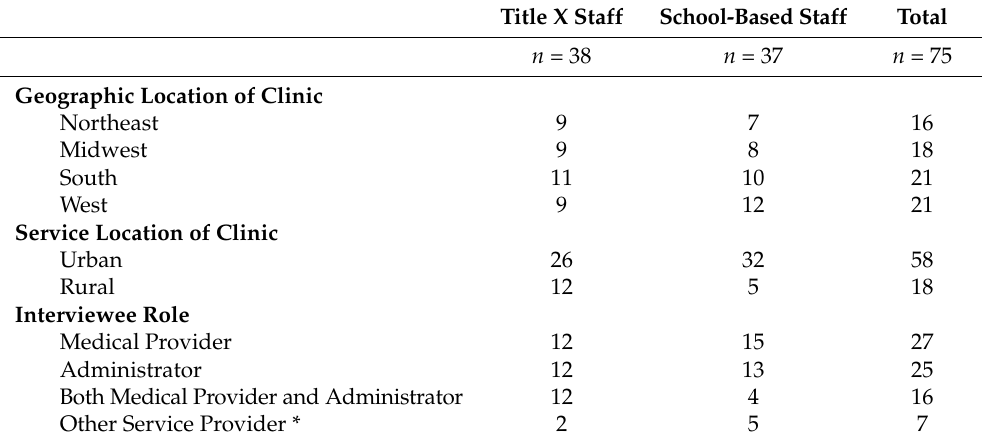
Table 1. Interviewee and clinic